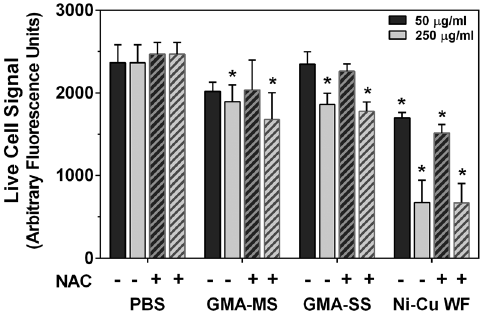
Figure 2. Reduced viability is not due to excessive ROS production. RAW 264.7 cells were pre-treated with and without N - acetyl-L-cysteine (NAC) for 1 h and then for 24 h with suspensions of welding fumes. MultiTox-Fluor Reagent (Promega) was added to all wells for 1 h at 37 u C, and plates were read at 400ex/505em to determine the fluorescence signal from live cells. Error bars represent the mean 6 SD (n=3). There was no significant difference between 2 and + NAC for treatment groups. *, p , 0.05 compared to PBS control.